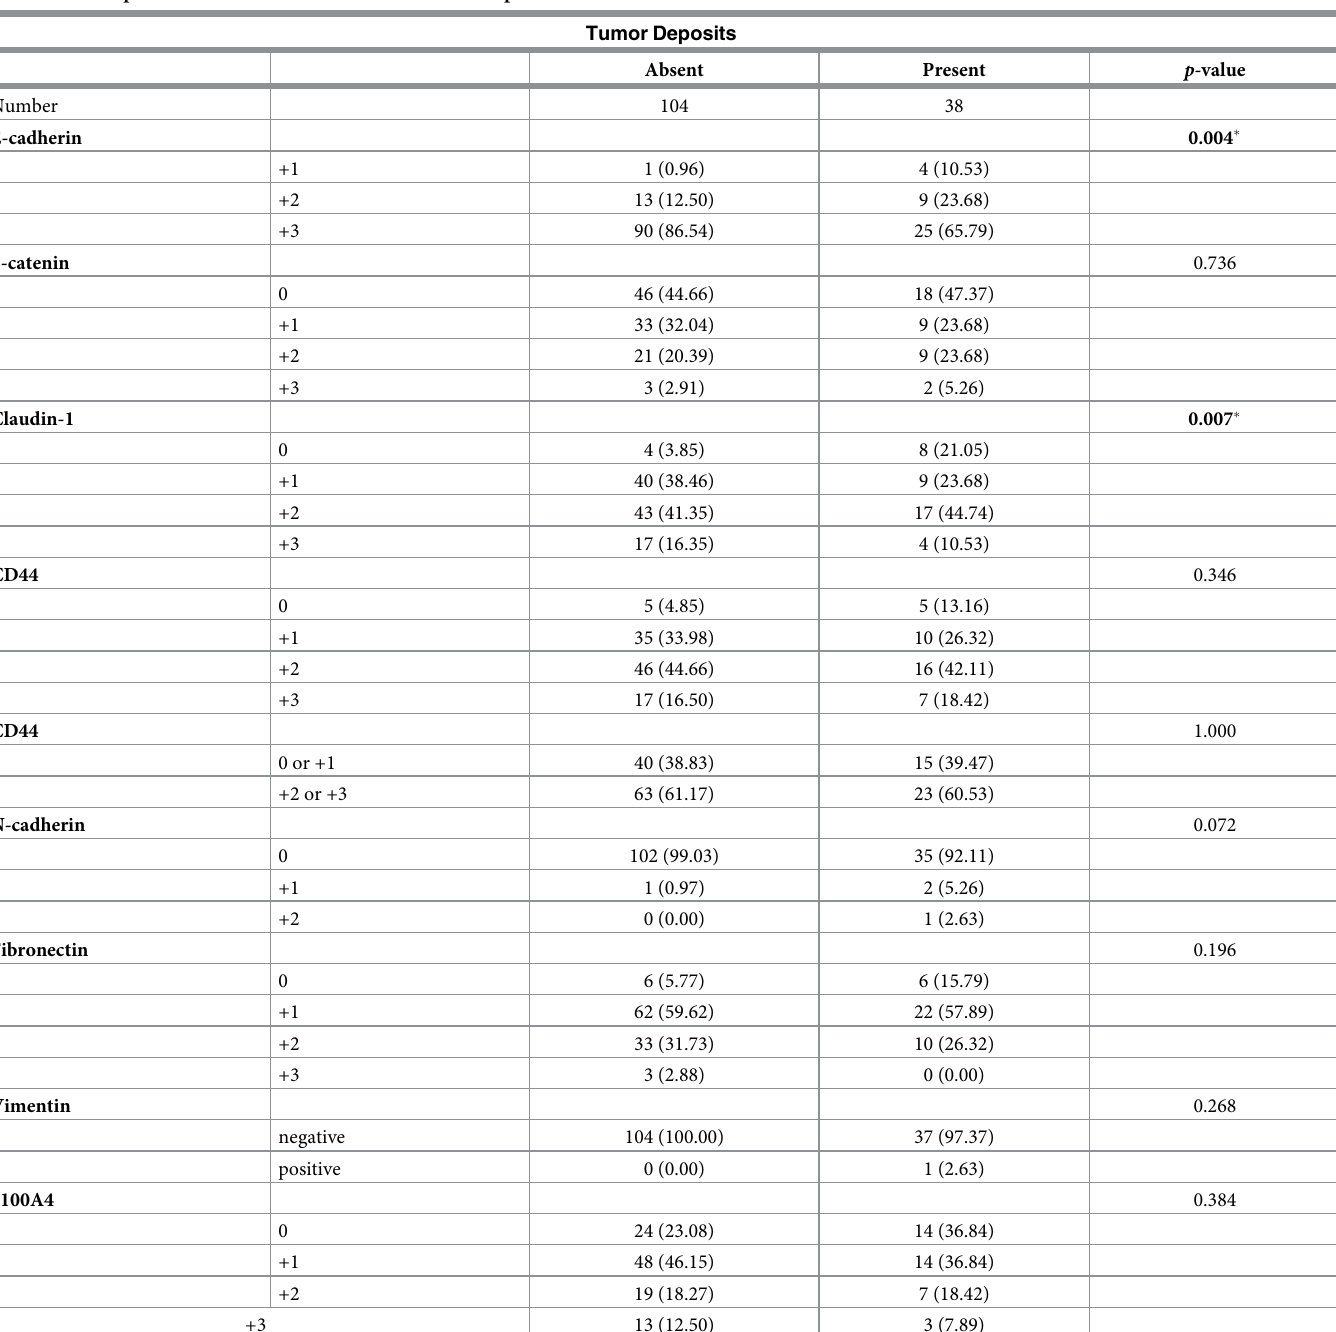
Table 7. IHC expression of EMT-related markers vs . tumor deposits.